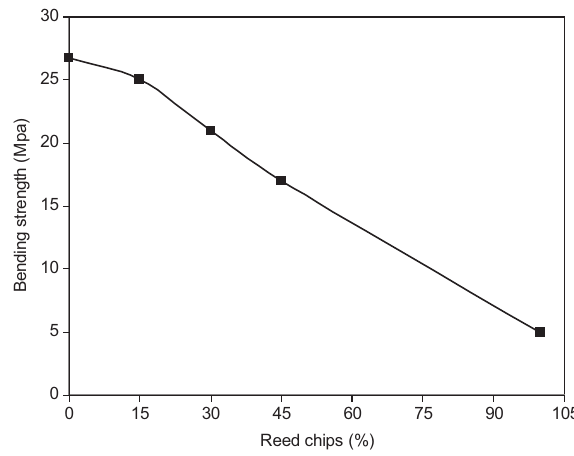
Figure 5 Effects of reed chips addition on bending